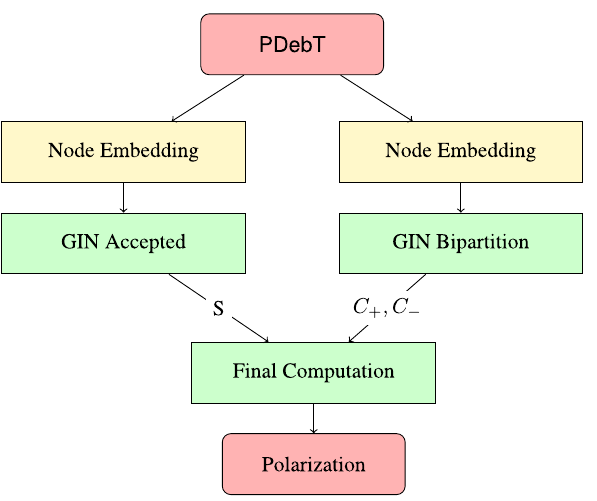
Fig. 3 2GNN model: Two GNN model architecture for computing the polarization degree of a Pruned Debate Tree